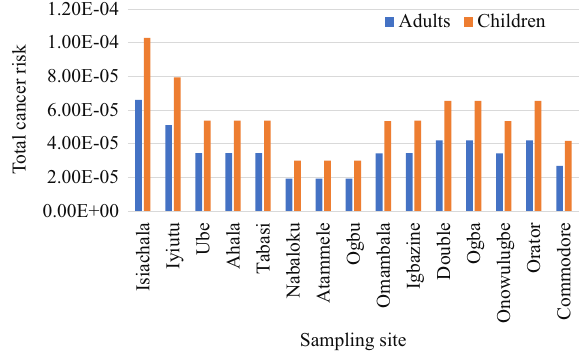
Fig. 9 Total cancer risk of populace across different sampling loca-